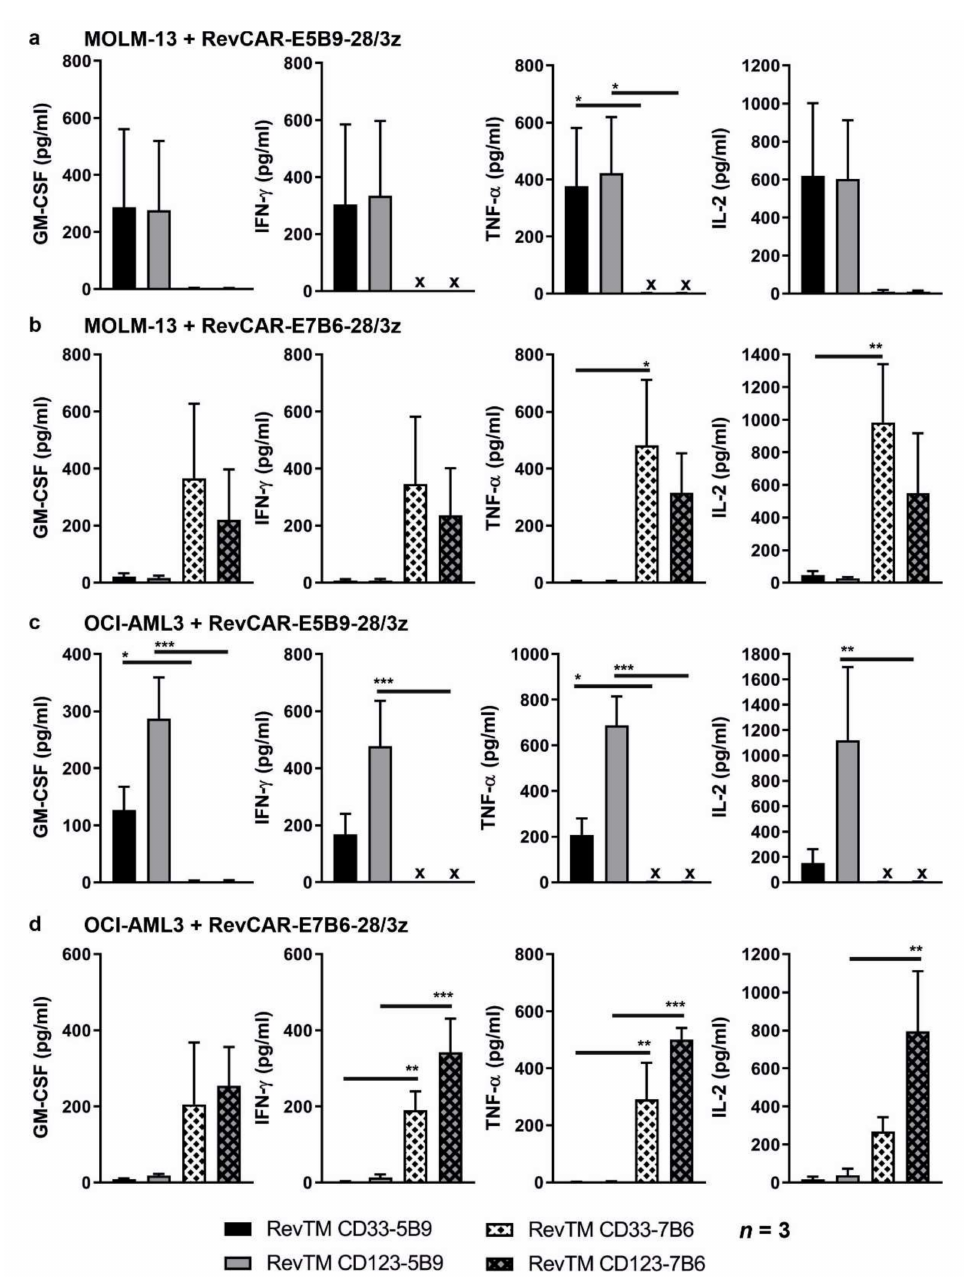
Figure 3. Cytokine release from redirected RevCAR T-cells. Release of indicated cytokines from redirected ( a , c ) RevCAR-E5B9-28/3z or ( b , d ) RevCAR-E7B6-28/3z T-cells co-cultured with ( a , b ) MOLM-13 or ( c , d ) OCI-AML3 cells at a ratio of 5:1 in the presence of RevCAR epitope matching RevTMs or irrelevant non-matching RevTMs used as negative controls was investigated. Cell cul- ture supernatants were harvested and analyzed. Data acquired for three individual T-cell donors represented as mean ± SD (One-way ANOVA with Tukey’s multiple comparisons test. Significance versus irrelevant RevTMs.). x, not detectable. p values below 0.0332 were considered significant: p < 0.0332 (*), p < 0.0021 (**), p < 0.0002